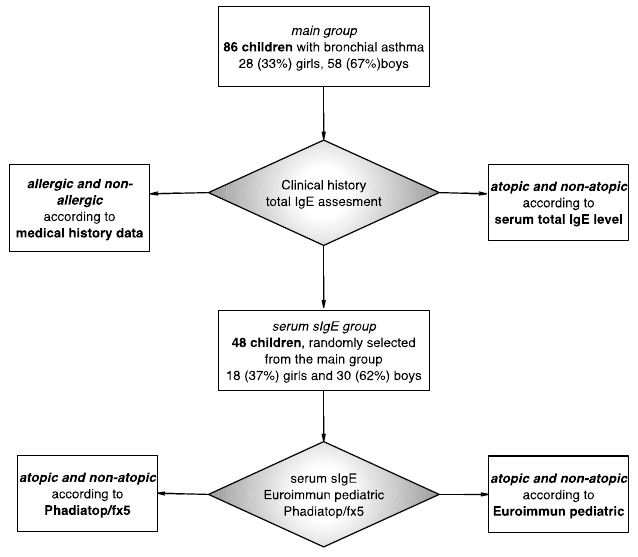
Figure 1. Study design.